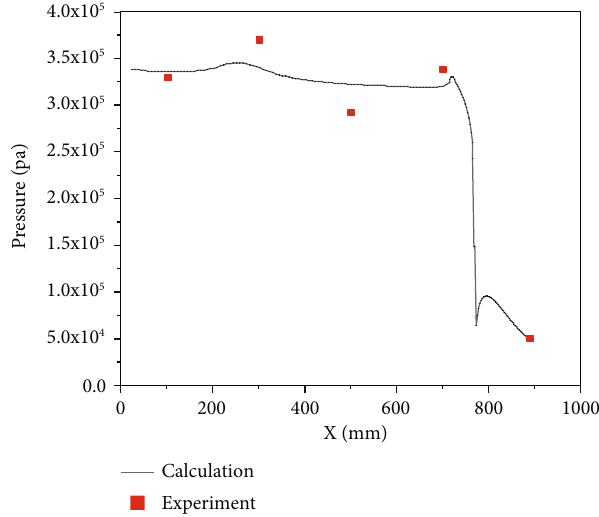
Figure 6: Comparison of pressure on line 1 for the simulation and experiment